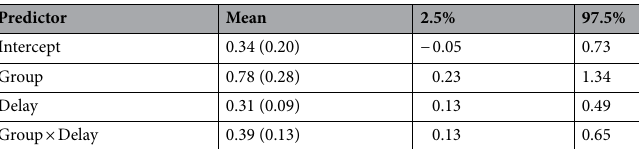
Table 3. Results of Bayesian MGLM for the bidding task, regressing differences between revealed and self- reported subjective values on predictors for Group (0 = nonsmoker, 1 = smoker), Delay, and the interaction term. We report the upper and lower borders of the 95% HDI of the posterior distributions. Standard errors of the mean are in brackets.